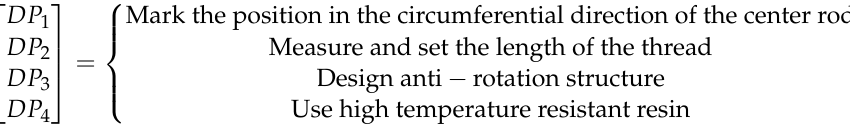
In the design matrix A , 1 means that there is a correlation between the design parame- ters, and 0 means that there is no correlation between the design parameters. This matrix is a coupling matrix and does not satisfy the independence axiom design. The associated design needs to be optimized and decoupled to form a triangular or diagonal array that meets the design